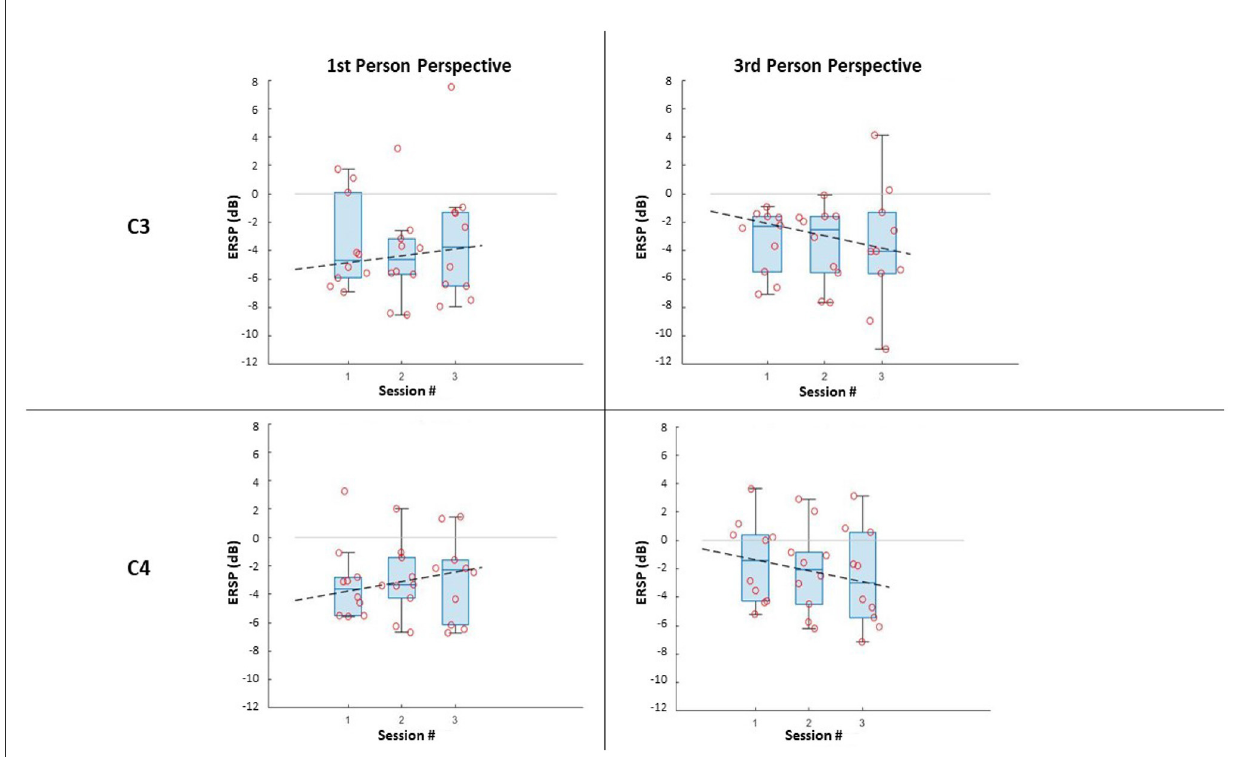
FIGURE3 ERSP distributions along sessions for MI right-hand trials: ERSP recorded in channel C3 and C4 in the first-person and third-person perspectives. The dashed lines represent the interpolation of the medians of each session.